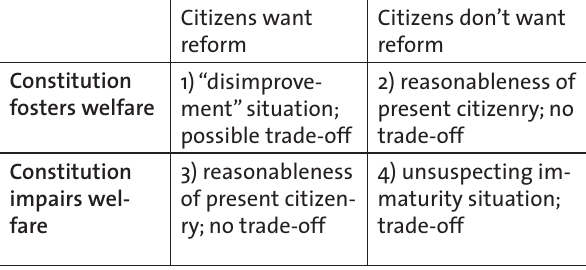
Figure 2: Trade­offs between quality and